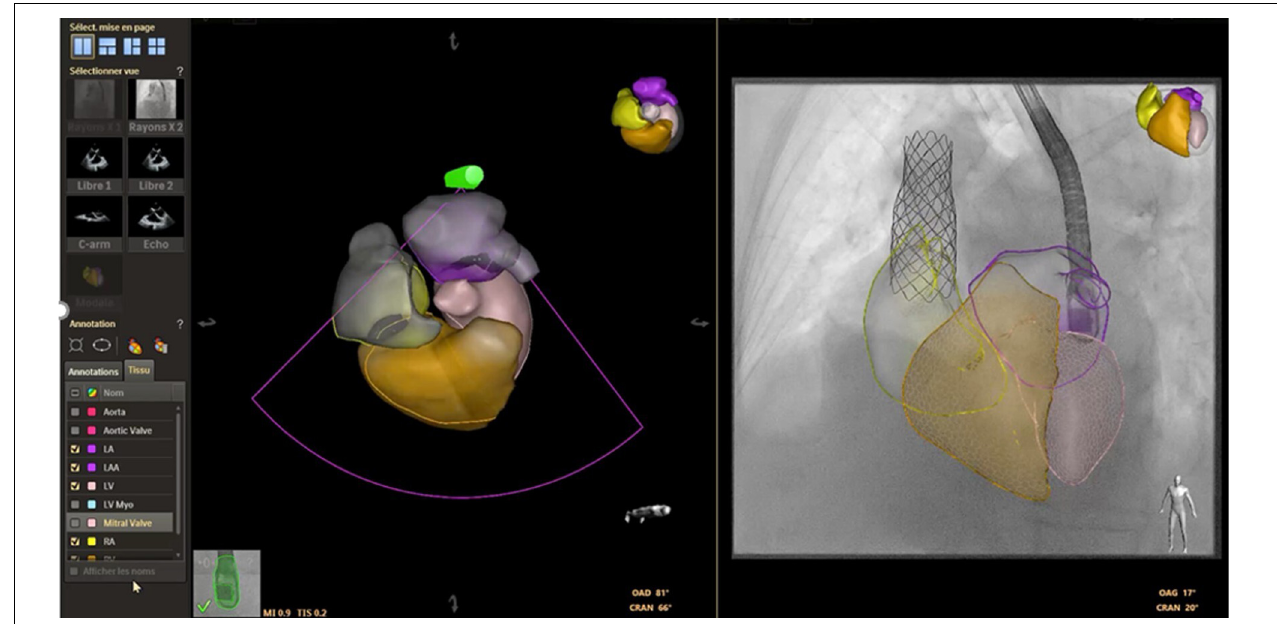
FIGURE 6 | Preprocedural simulation of sinus venosus atrial septal defect percutaneous closure. Courtesy of Philips Healthcare .